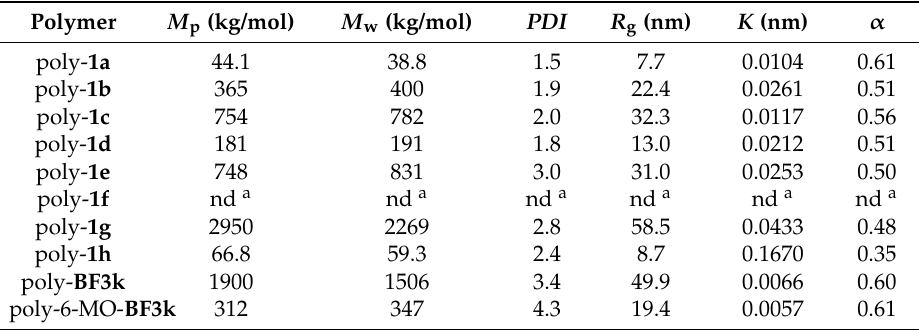
Table 1. Macromolecular features of the newly synthesized poly- 1a – h compared with those of the previously reported poly- BF3k and poly-6-MO- BF3k